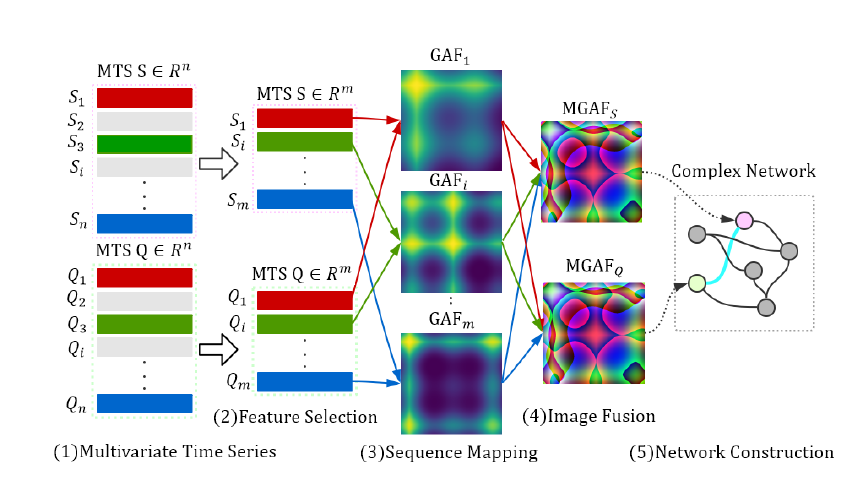
Figure 1. Architecture of our proposed method. The whole process of our method contains five steps. (1) Selected representative sub-time series to form a new multivariate time series (MTS). (2) Converted sub-time series to a Gramian angular field (GAF) grayscale image. (3) Fused multiple grayscale images into a color image. (4) Added nodes to the complex network. (5) Determined edges between nodes by the similarity between fused